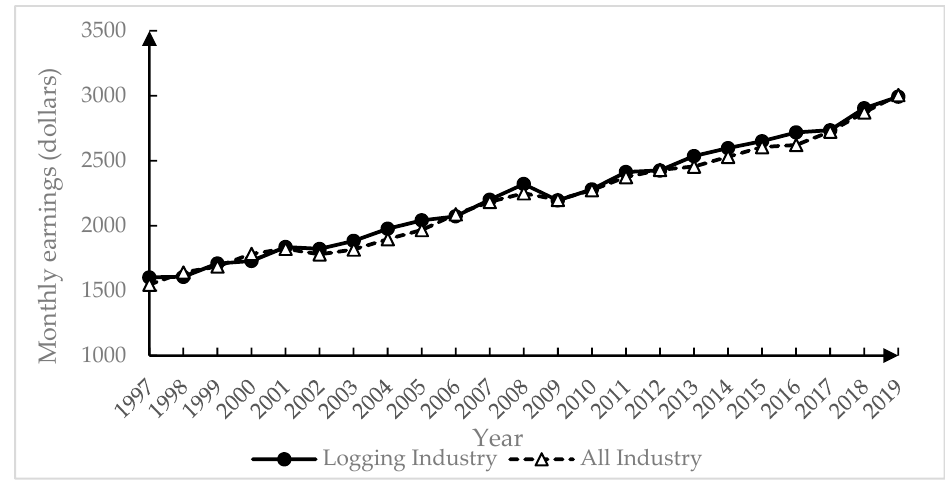
Figure 1. Average monthly earnings of newly stable employees in the logging industry and all industries, U.S., during 1997 to 2019 [38].